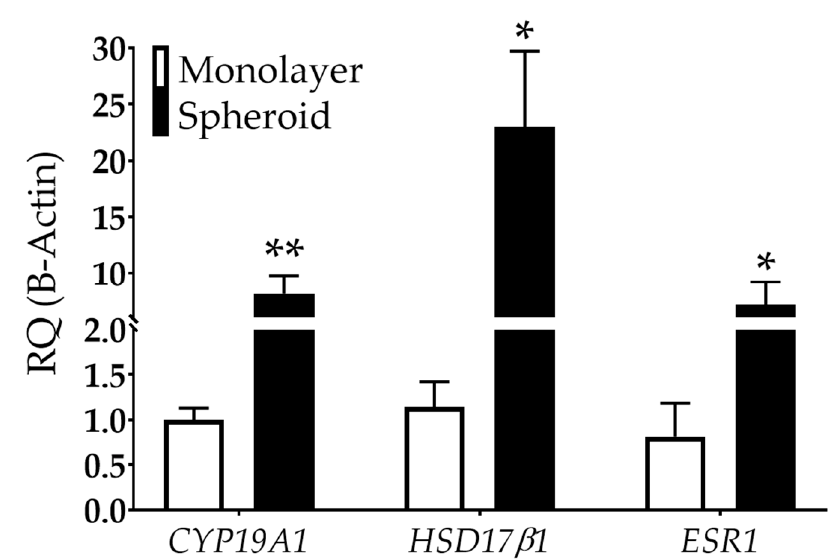
Figure 5. Estrogen-related gene expression is dependent on dimensionality in 12Z cells. CYP19A1 and HSD17 β 1 , genes involved in estrogen synthesis, are upregulated in 12Z cells grown as spheroids compared to monolayer. ESR1 , an estrogen receptor, is also increased in spheroids compared to monolayer. RQ = relative quantification. N ≥ 3. * p < 0.05, ** p < 0.01.